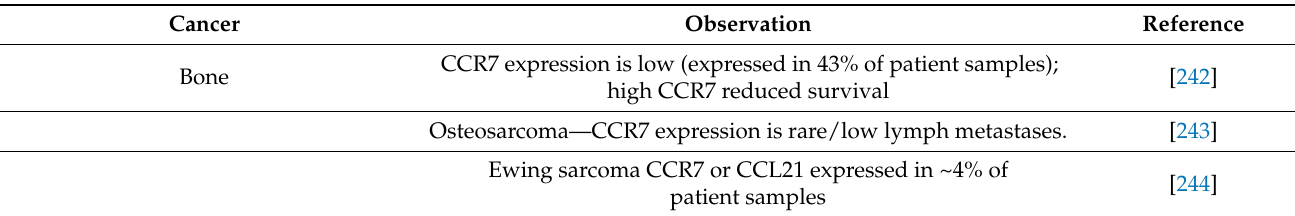
Table 6. Hematopoietic/bone. Cancer Observation Reference CCR7 expression is low (expressed in 43% of patient samples); Bone high CCR7 reduced survival Osteosarcoma—CCR7 expression is rare/low lymph metastases. Ewing sarcoma CCR7 or CCL21 expressed in ~4% of patient